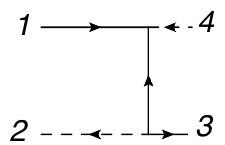
Figure 1. Kernel of the h i ( (cid:28) 1 ) b i ( (cid:28) 2 ) (cid:22) j ( (cid:28) 3 )(cid:22) b j ( (cid:28) 4 ) i correlation. Iterating this kernel generates all ladder diagrams, which dominate the large- N limit of the connected 4-point